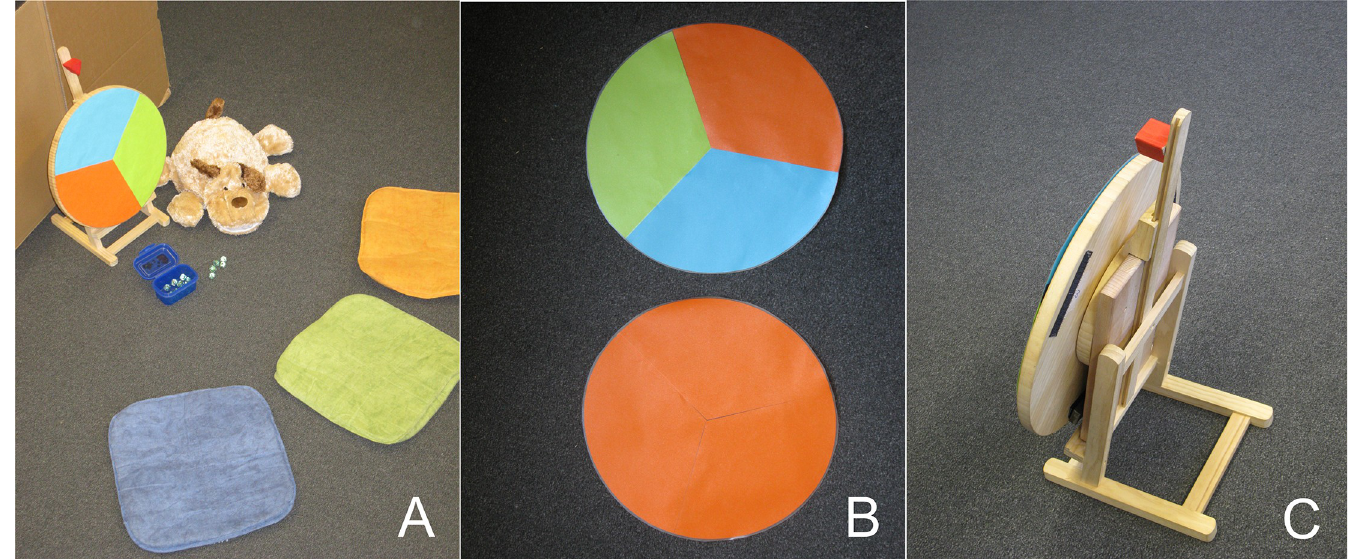
Fig 1. Material and set-up. (a) Set-up for the warm-up with colored cushions for the children to sit on, a fair wheel of fortune with each of the colors on it and the stuffed animal dog, (b) two wheel covers used in the test (fair–all three children could get the big sticker box, unfair: only the tested child sitting on the orange cushion could get the big sticker box), the chosen cover was attached to the wheel dummy and then the wheel was spun once, (c) back of the wheel with a weight attached to it. The weight could be fixed to three different positions on the back of the wheel to determine the final position after spinning.